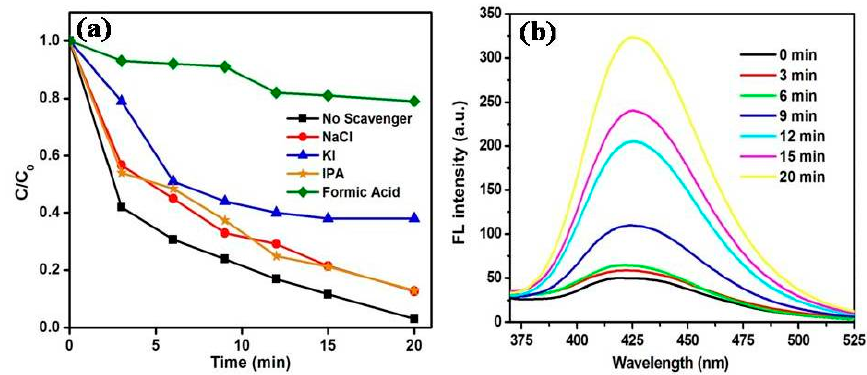
Figure 11. ( a ) Effect of scavengers on the photodegradation of MB over the MoS 2 /ZnO heterostructure and ( b ) fluorescence spectra of TPA over the synthesized MoS 2 /ZnO heterostructure under solar light